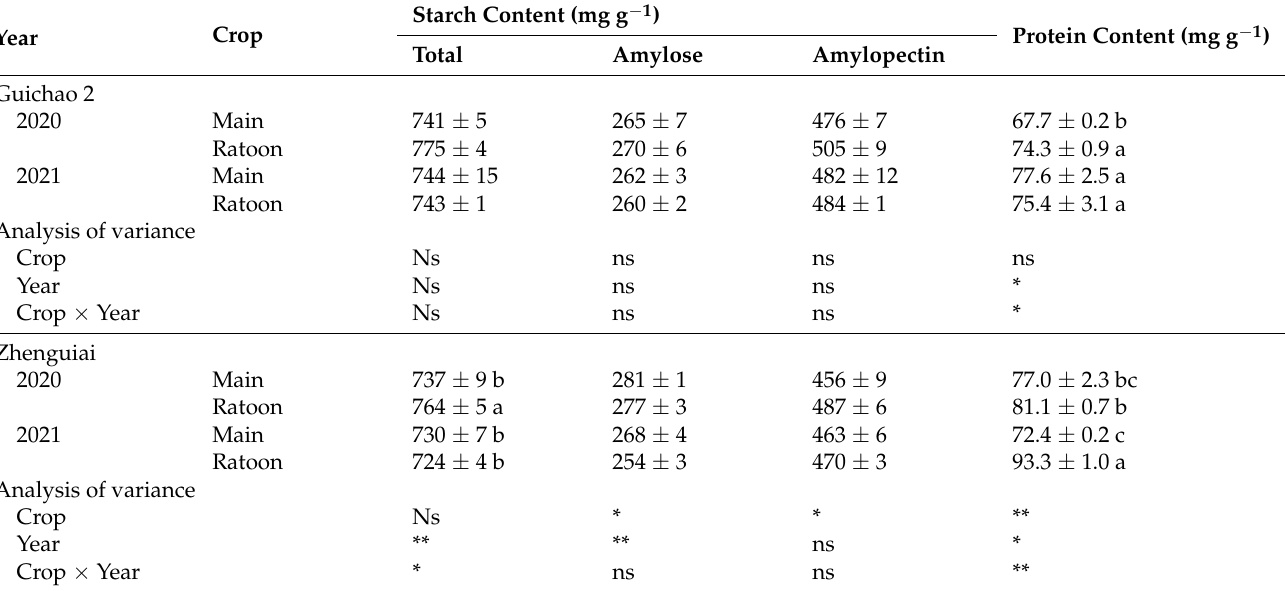
Table 4. Starch and protein contents in milled rice flour of main and ratoon crops of two cultivars, Guichao 2 and Zhenguiai, grown in 2020 and